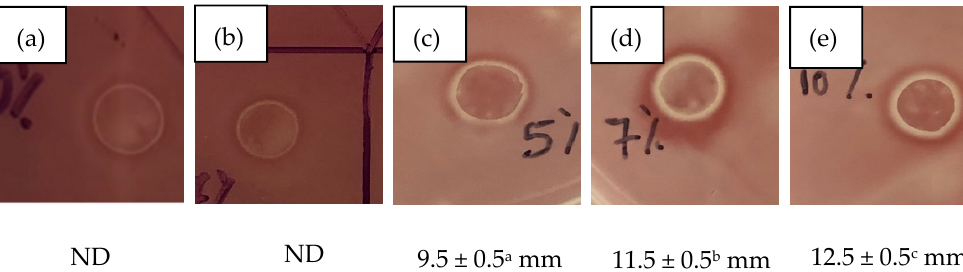
Figure 5. Antimicrobial activity of starch/CNF bionanocomposite films after 24 h of incubation at 37 ◦ C incorporated with: ( a ) 0, ( b ) 3, ( c ) 5, ( d ) 7, and ( e ) 10 wt.% thymol. ND: No inhibition zone was detected. Different superscripts indicate a statistically significant difference ( p < 0.05).